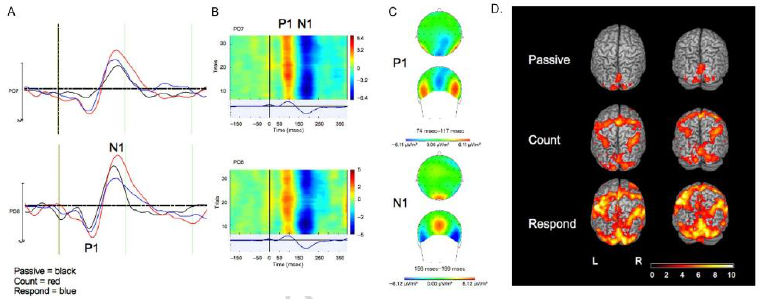
Figure 5. ( A ) Grand average of ERPs at PO7 and PO8 with the P1 and N1 peaks marked. ( B ) Stacked plots of single-trial responses at PO7 and PO8 for a representative subject, illustrating a consistent positivity for the P1 component and a consistent negativity for the N1 component. ( C ) Topography of the P1 (top) and N1 (bottom) components. ( D ) BOLD activation (z scores) in response to target stimuli in the Passive, Count, and Respond conditions (second-level mixed-effects FLAME, n = 13, Cluster-corrected threshold Z = 2.0, p = 0.05). Reproduced with permission from Ref. [97]. Copyright 2014 MIT